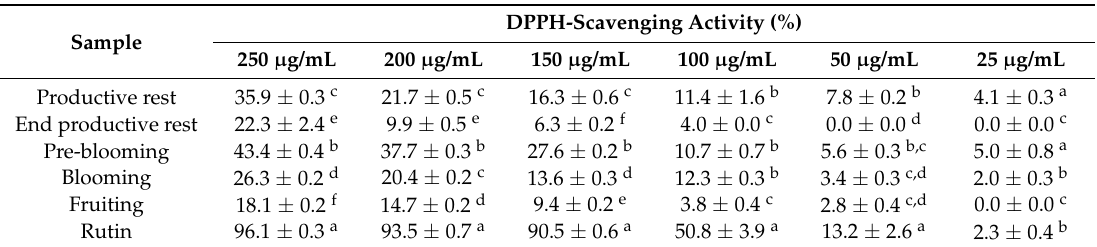
Table 4. Radical DPPH-scavenging activity of essential oils from the leaves of Nectandra